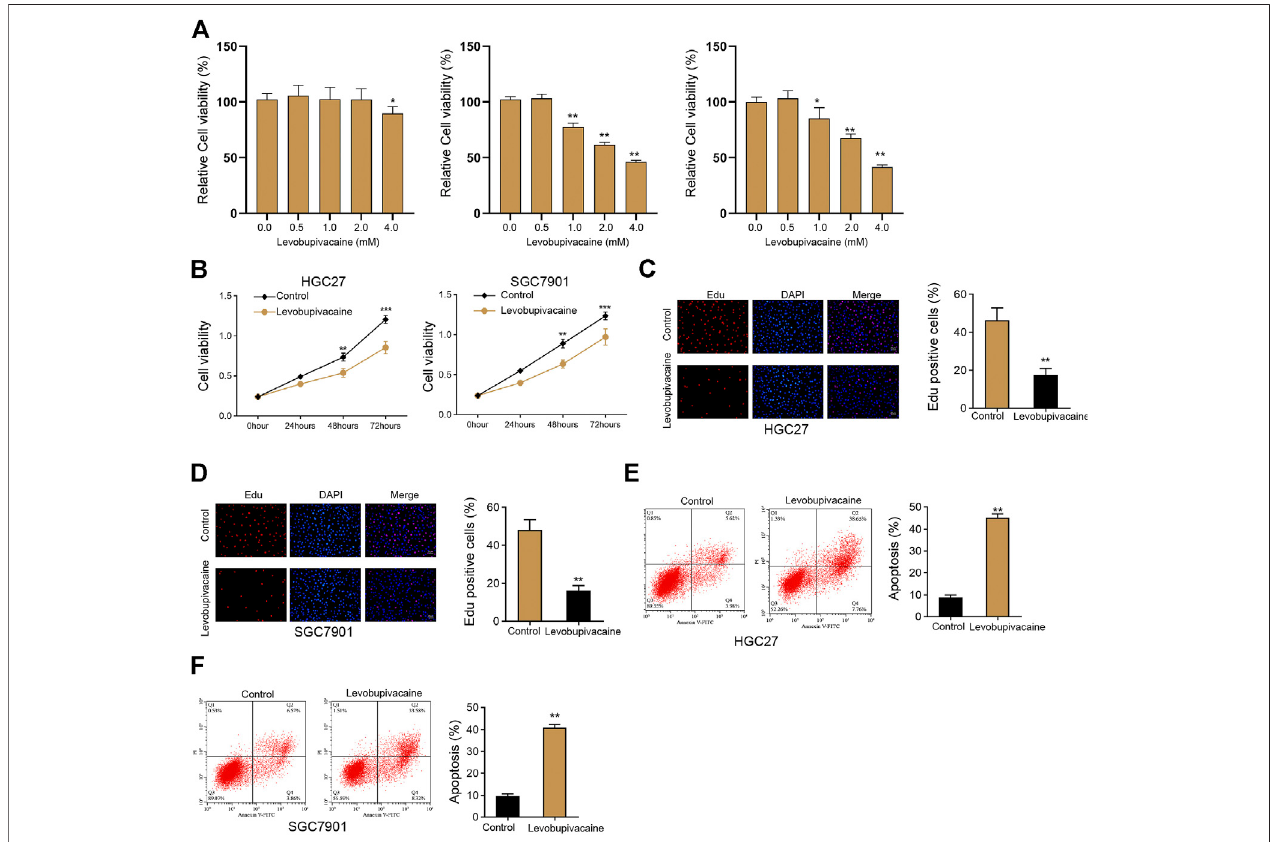
FIGURE1| Levobupivacainerepressessurvivalofgastriccancercells invitro . (A) TheGES-1,HGC27,andSGC7901cellsweretreatedwithlevobupivacaineatthe indicatedconcentrations.MTTassaysforcellviabilityanalysis. (B – E) HGC27andSGC7901cellsweretreatedwithsalineorlevobupivacaine(2 mM). (B) MTTassaysfor cell viability analysis. (C,D) Edu assays for cell proliferation analysis. (E,F) Flow cytometry analysis of apoptosis. The experiments were performed independently three times (mean ± SD, ** p < 0.01).